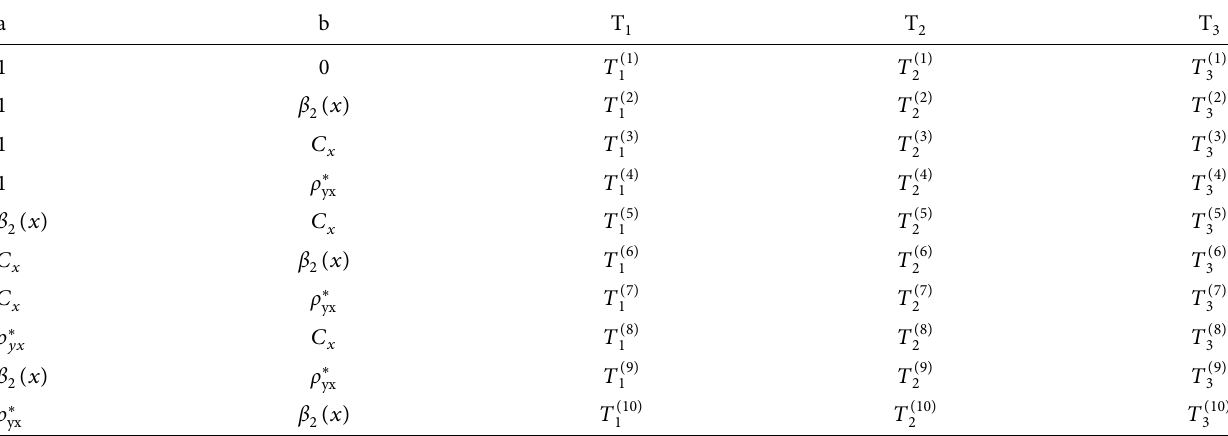
Table 1: Some members of the proposed class of